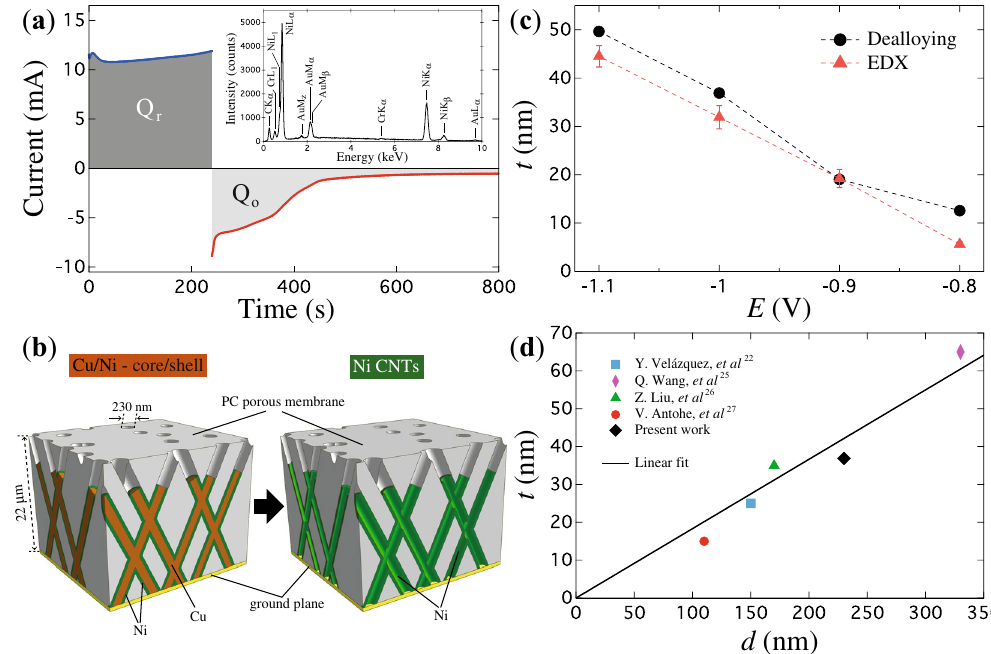
Figure 2. ( a ) Reduction and oxidation curves at the respective potentials of − 1.0 V and + 0.2 V in order to obtain an initial core(Cu)/shell(Ni) nanocable network and the successive CNT network into a PC membrane with crossed nanopores. The inset shows the EDX spectrum of the CNT network after the complete dealloying process is finished. ( b ) Schematic representations of the cross section of a 3-D crossed core(Cu)/shell(Ni) nanocable network and the successive 3-D CNT network obtained after dealloying of the Cu core. ( c ) Variation of the nanotubes wall thickness t as a function of the reduction potential E obtained using equation (1) with: r given in terms of the reduction and oxidation charges, which are computed as the integral area beneath the corresponding electrochemical curves (circles) and; with r given in terms of the core and shell volumes, which correspond respectively to the atomic % of Cu and Ni obtained from EDX mappings (triangles). The error bars for the t values obtained from EDX mappings correspond to the standard deviation from the statistical mean value. ( d ) Plot of t vs. d for the CNT network at E = − 1 V (lozenge) obtained with equation (1), which is compared to the values reported in the different previous works on parallel NT networks 22,26–28 . The linear regression is carried out to the whole set of t vs d values with a fitting accuracy of